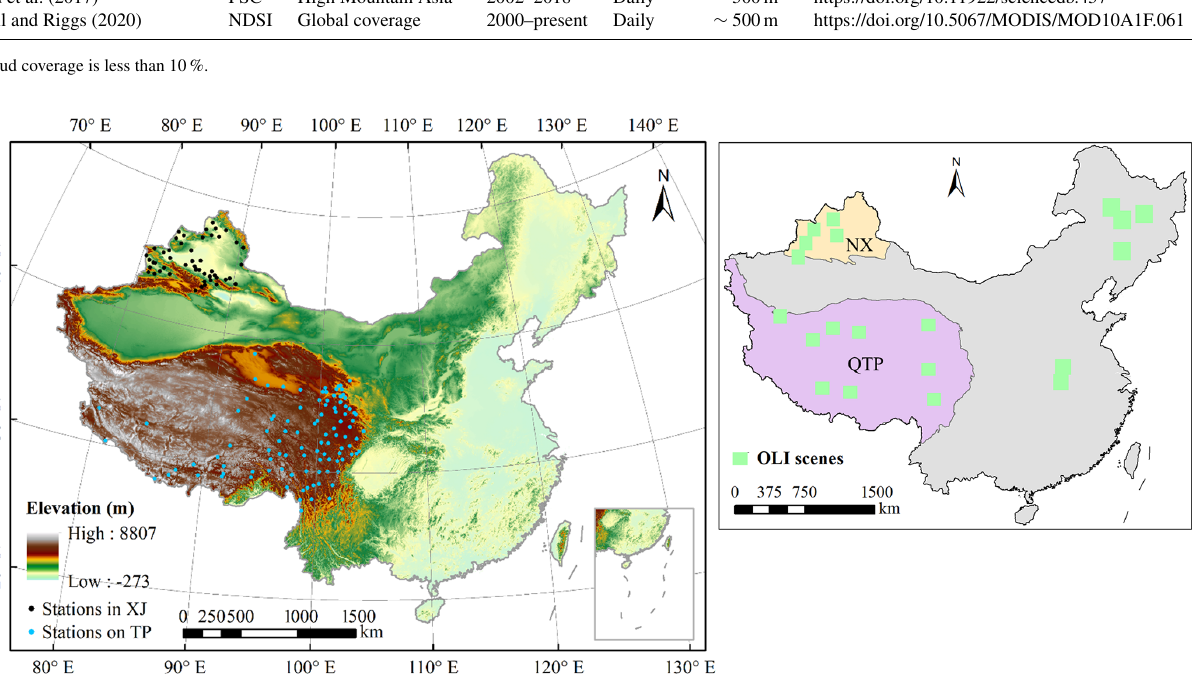
erage preliminarily. Its priority scheme is determined as high value > low value >